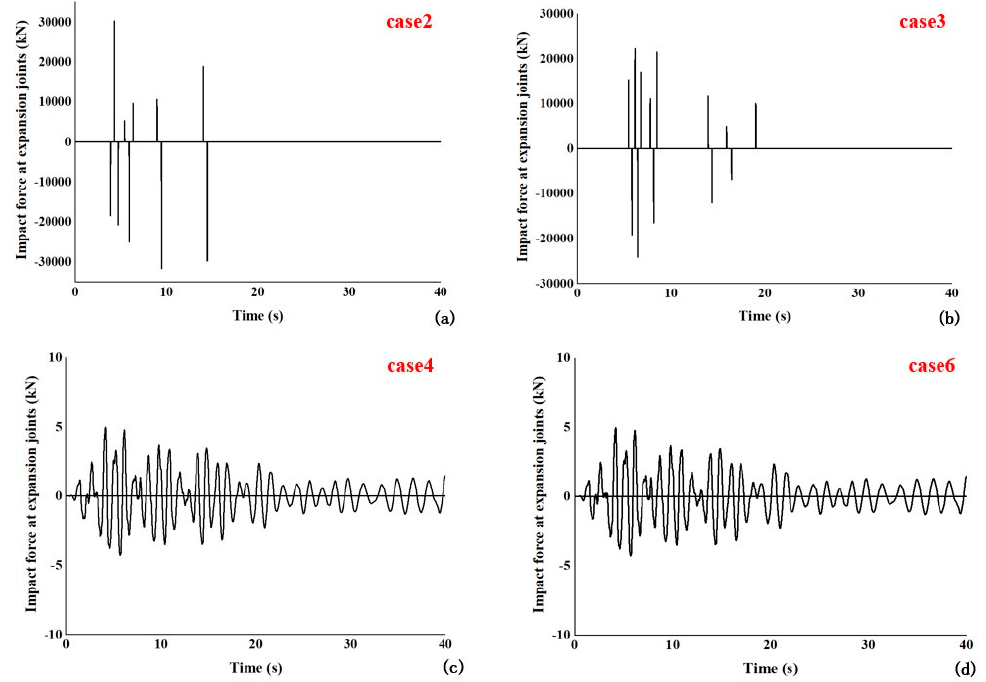
Figure 12. Impact force at expansion joints under a large earthquake: ( a ) Case 2, ( b ) Case 3, ( c ) Case 4, and ( d ) Case 6.